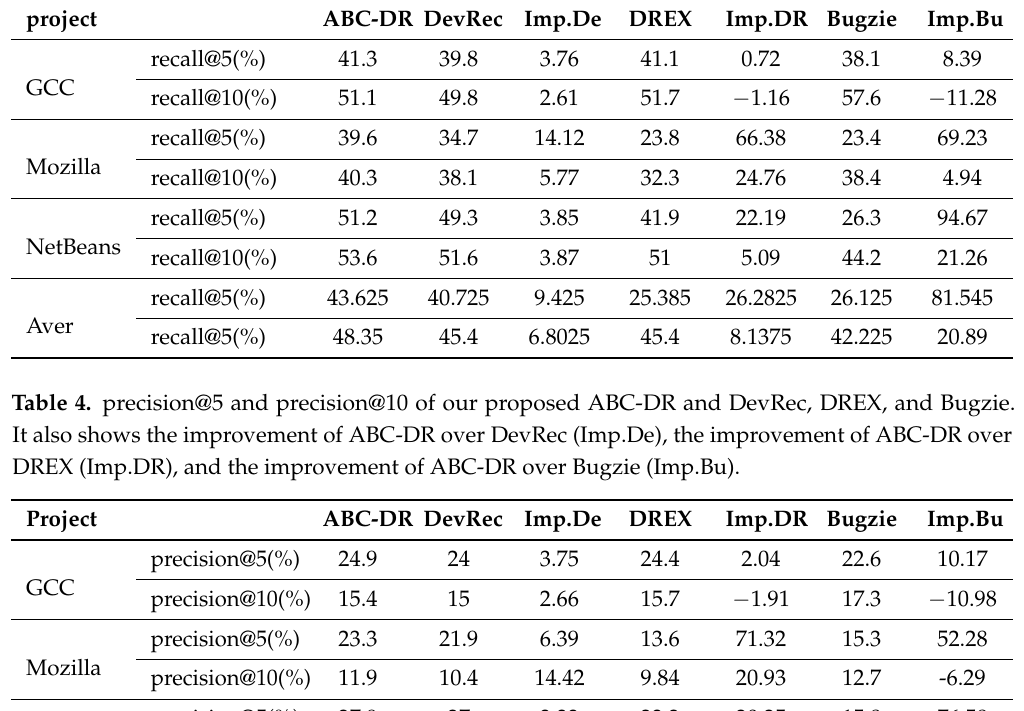
Table 3. recall@5 and recall@10 of our proposed ABC-DR and DevRec, DREX, and Bugzie. It also shows the improvement of ABC-DR over DevRec (Imp.De), the improvement of ABC-DR over DREX